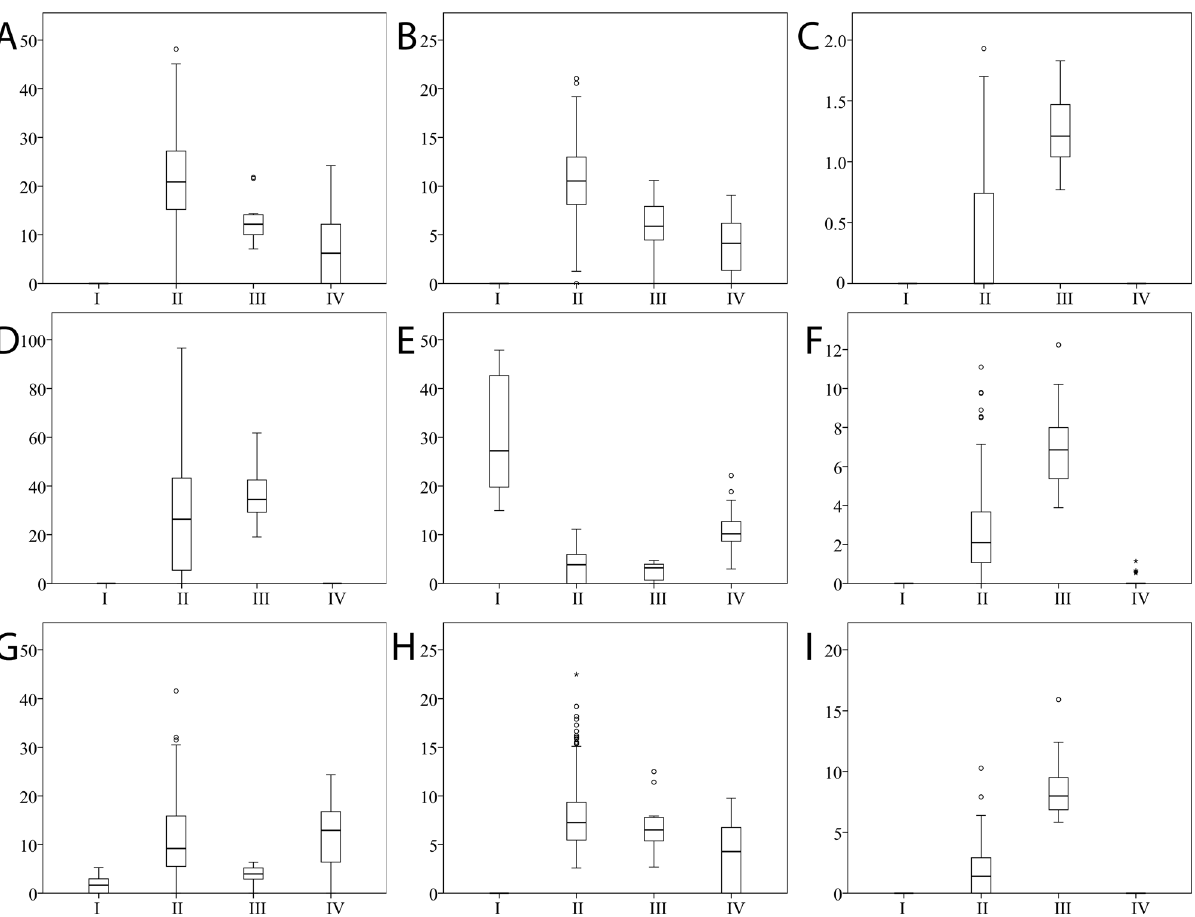
Fig 3. Boxplots stratified on the 4 clusters showing peak intensities across the sample population for the 9 peaks determining the clustering structure. X-axis contains the 4 clusters. Y-axis contains the peak intensity, scaled from 0 (minimum detection level) to 100 (maximum detected intensity of any peak across all samples and peaks). Peaks are listed in decreasing order of their importance for the clustering, same as in Table 2. (A) P-C peptide, Fr. 15 – 44. (B) P-C peptide, Fr. 1 – 25. (C) unidentified peak (m/z = 5980). (D) P-C peptide (1 + charge). (E) unidentified peak (m/z = 2725). (F) Cystatin B, Fr. 1 – 53. (G) P-C peptide, Fr. 15 – 35. (H) P-C peptide (2+ charge). (I) II-2 basic proline-rich protein,